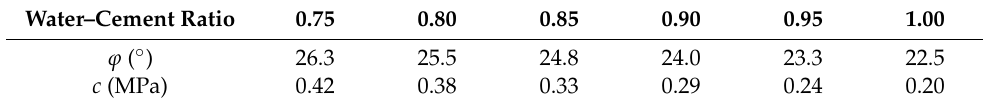
Table 2. Shear strength parameters of grouted surrounding rock with different water–cement